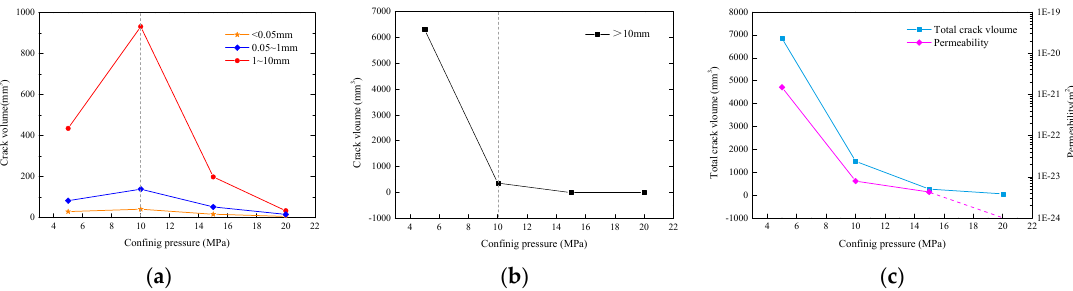
Figure 17. Crack analysis of pure salt after failure under different confining pressures. ( a ) d c < 0.05 mm, 0.05 ≤ d c < 1 mm, and 1 ≤ d c < 10 mm; ( b ) d c ≥ 10 mm; ( c ) Permeability and total pore volume versus confining pressure.